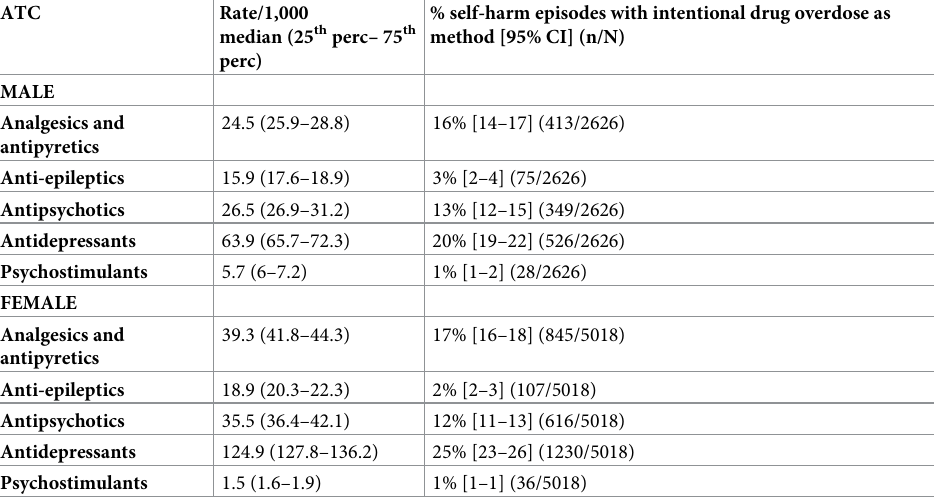
Table 2. Rate of prescriptions, percentage of self-harm episodes with intentional drug overdose as method in Flanders from 2008 to 2013.